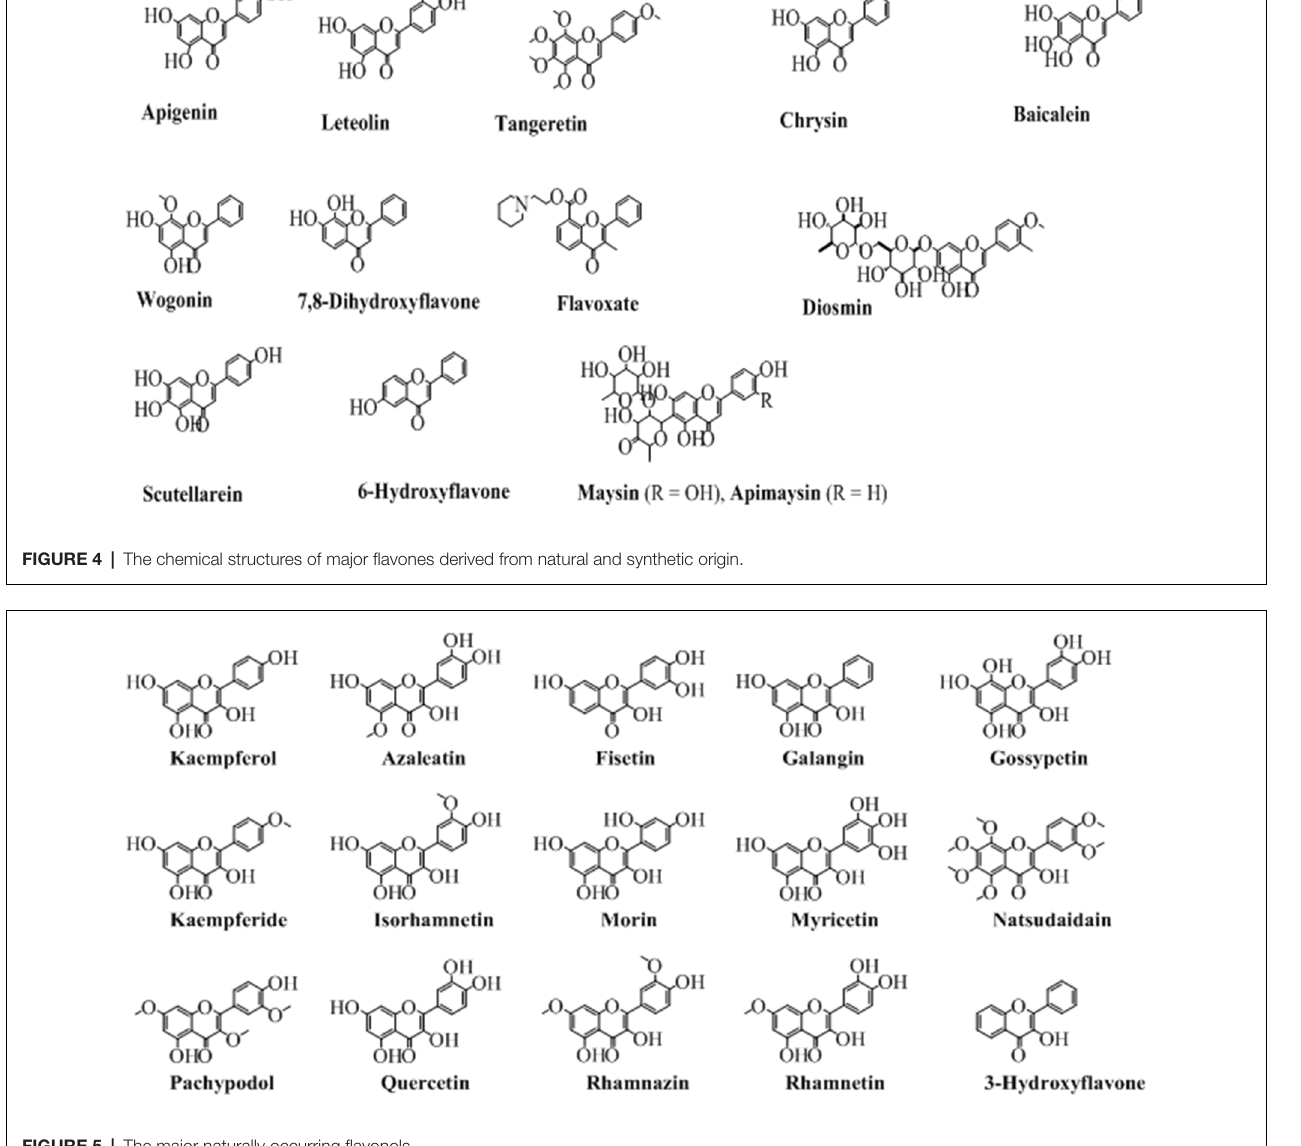
FIGURE 5 | The major naturally occurring